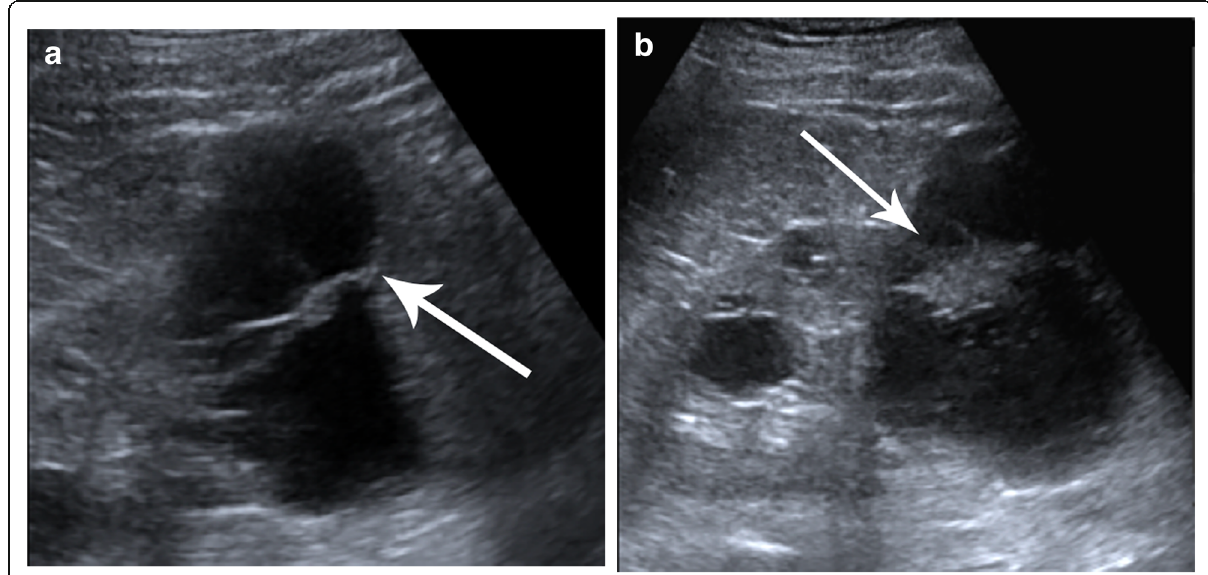
Fig. 18 Cystic Bosniak IIF renal mass (arrows) presenting growth over time and showing malignant features with an occurrence rate of 5%. a Unenhanced US showing a cystic renal lesion with thickened septa. b Unenhanced US of the same lesion 1 year later showing increasing nodularity in the previously thickened septa, consistent with progression